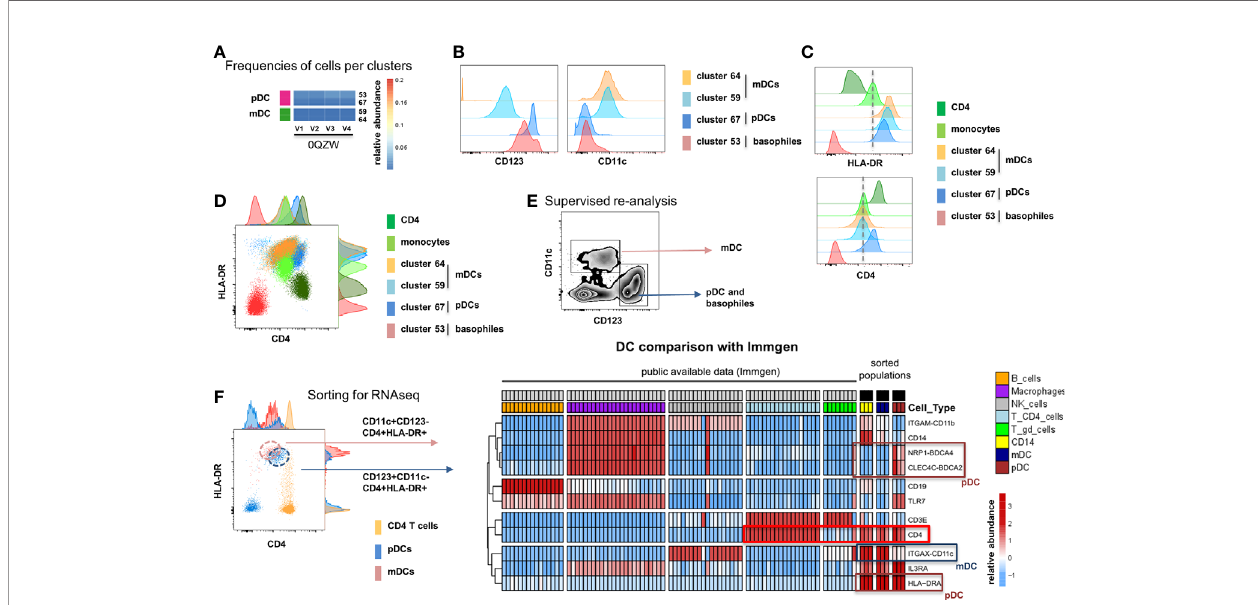
FIGURE 5 | Identi fi cation of multiple mDC and pDC subsets by MegaClust. (A) Comparison of the different clusters identi fi ed by MegaClust as mDCs and pDCs (example for one patient for four time points). (B) Expression level of CD123 and CD11c of the two mDC clusters and the two pDC clusters identi fi ed by MegaClust. (C) Expression levels of HLA-DR and CD4 for the two pDC clusters and the two mDC clusters identi fi ed by MegaClust. Cluster 53 could be assigned as basophils due to the lack of expression of CD4 and HLA-DR (25). The expression of CD4 is shown for CD4 T cells and CD14 + monocyte clusters for comparison. (D) Overlay of CD4 and HLA-DR of MegaClust identi fi ed clusters for mDC, pDC, basophils, CD4 and monocytes. (E) mDCs and pDCs were discriminated according to CD11c and CD123 expression in the supervised fl ow cytometry re-analysis according to the new gating strategy described in Supplementary Figure 5 (one representative patient 0QZW). (F) Representative illustration of HLA-DR and CD4 co-expression on mDCs and pDCs prior to FACS sorting CD11c+CD123 - CD4 + HLA-DR+ mDCs and CD123 + CD11c - CD4 + HLA-DR + were FACS sorted (dotted lines). (G) Gene expression pro fi les of fl ow cytometry sorted CD11c + CD123 - CD4 + HLA-DR + mDCs, CD123 + CD11c - CD4 + HLA-DR + CD4 + HLA-DR + pDC and CD14 + CD16 - monocytes from 3 healthy donors are shown in comparison to the RNA expression pro fi le of public available RNAseq datasets (Immgen) indicating the gene expression pro fi le of B cells, macrophages, CD4 T cells, g d T cells and NK